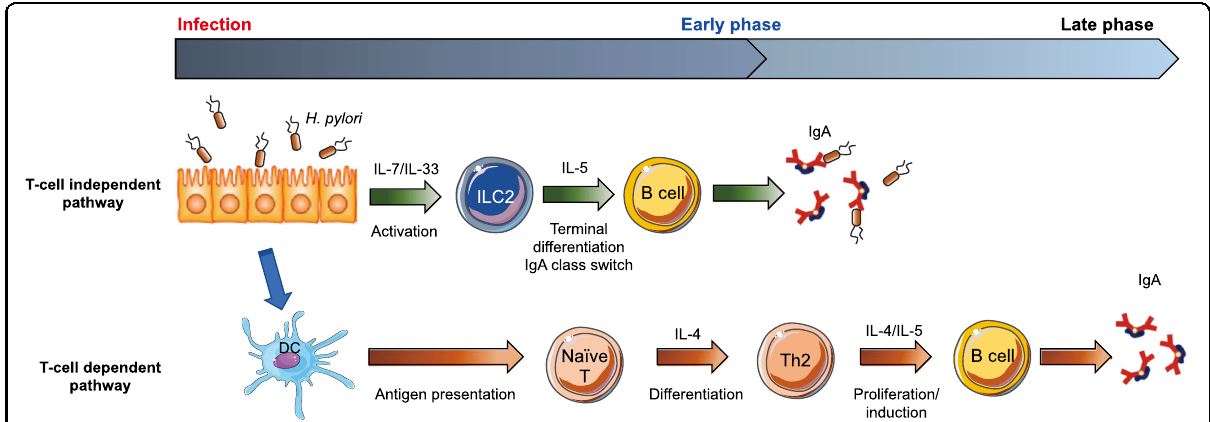
Fig. 3 The role of stomach ILC2s in H. pylori infection. In the early phase of H. pylori infection, the induction of IL-7 and IL-33 in the stomach tissue increases and activates ILC2s to secrete IL-5, which promotes plasma B cells differentiation and IgA production. At this stage, there is no apparent increase in CD4 + T cells (T-cell-independent pathway). In the later phase of the infection, IL-5 derived from Th2-type CD4 + T cells also promotes IgA production (T-cell dependent